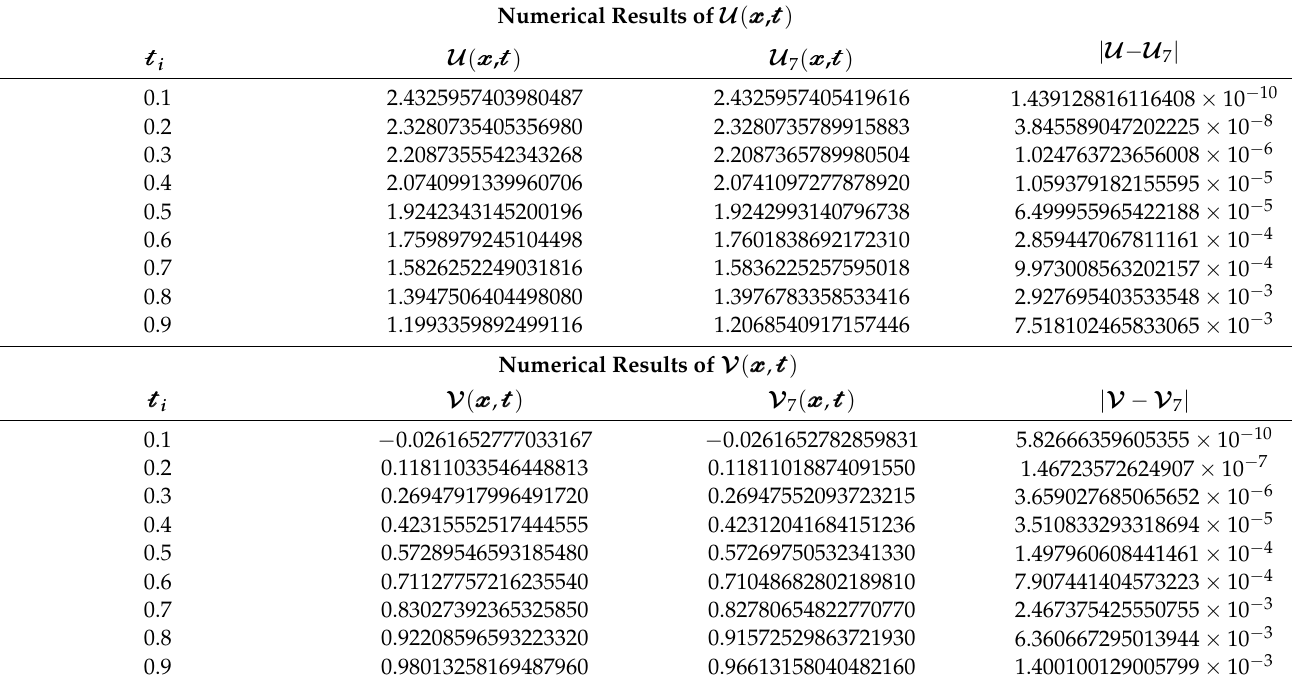
Table 1. Numerical results for Example 1 at 𝓍 = 1, 𝒶 = 1, and n = 7. Numerical Results of U ( 𝓍𝓍𝓍 , 𝓉𝓉𝓉